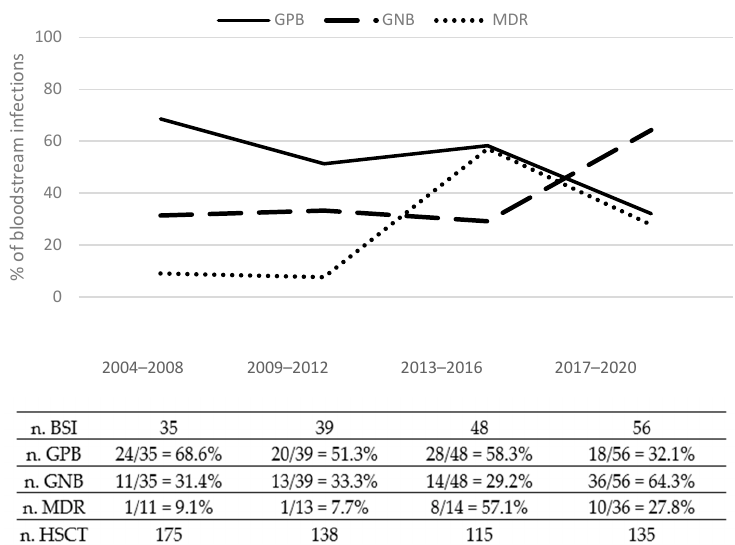
Figure 3. Trend of GPB, GNB, and MDR bacteria from 2004 to 2020 in our cohort. Vertical axis represents the percentage of type of infection on total BSI; horizontal axis indicates the four time periods analyzed. The table below shows absolute numbers. According to Fisher’s exact test, GPB over GNB ratio signi fi cantly changed over time ( p < 0.001).